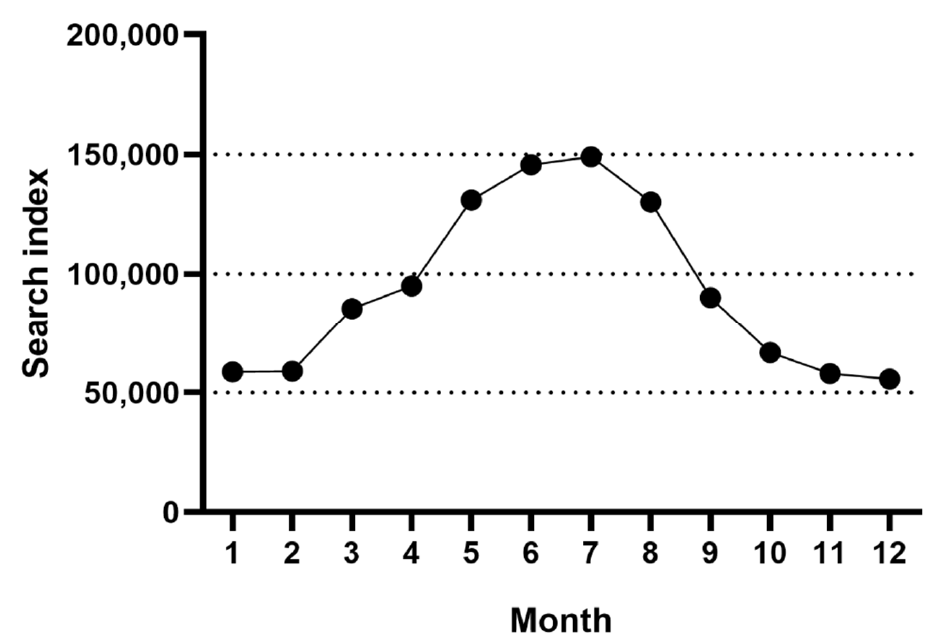
Figure 1. The search index of mosquito repellents in China in 2021.